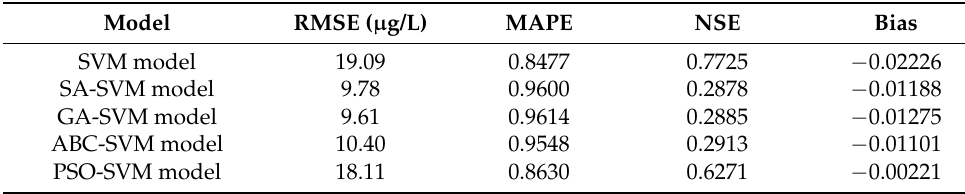
Table 5. The simulation error comparison of each model.